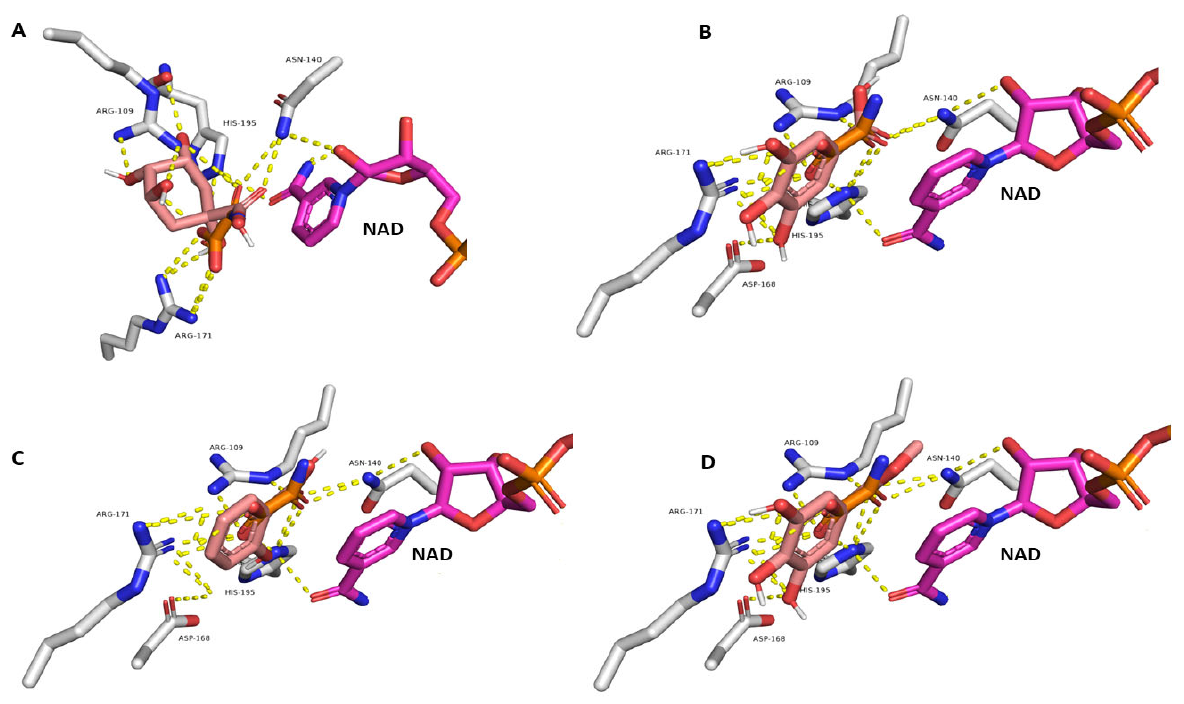
Figure 5. ( A – D ): Binding modes of quinic acid, gallic acid, hydroxybenzoic acid, and methyl gallate inside the active site of C. parvum -derived lactate dehydrogenase (PDB ID: 4ND1). The four structures (in brick-red color) are aligned with the structure of the co-crystalized inhibitor oxamic acid (in orange color). The structure of the co-factor nicotinamide adenine dinucleotide (NAD) is shown in pink color.